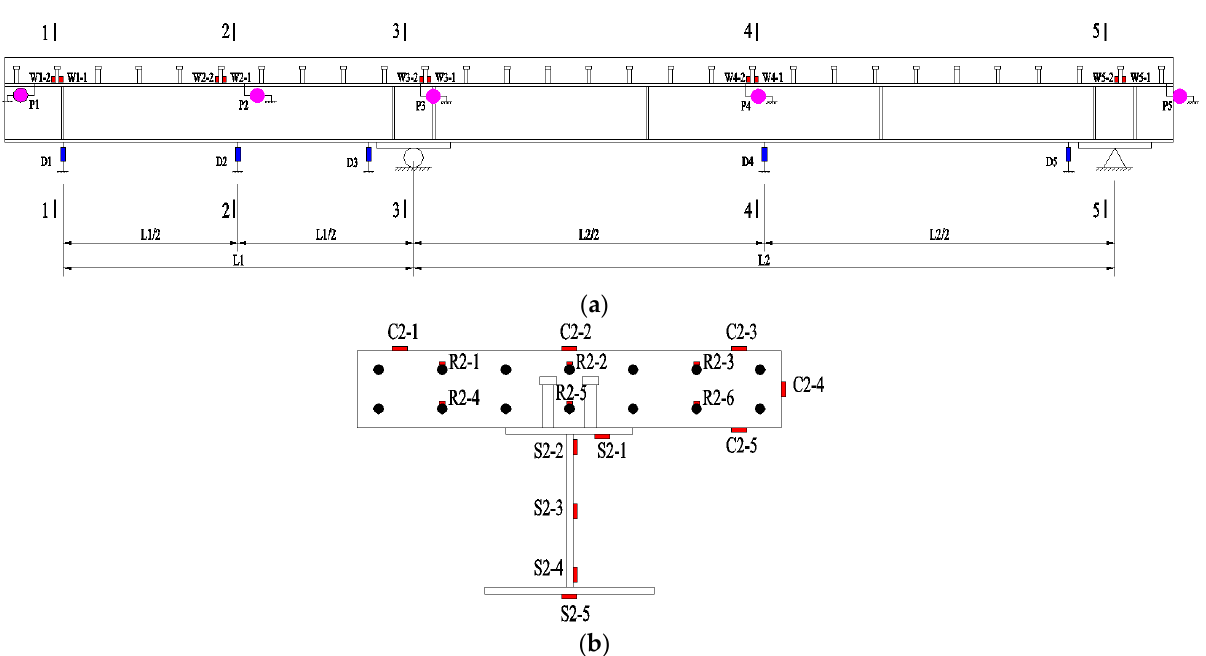
Figure 4. Instrumentation arrangement on a specimen. ( a ) Gauges of deflection, slip, and strain of studs. ( b ) Strain gauges of concrete, steel beam, and steel bar at Section 2-2. studs. ( b ) Strain gauges of concrete, steel beam, and steel bar at Section